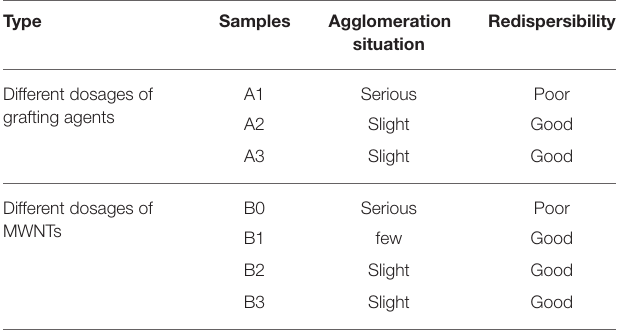
TABLE 3 | Redispersibility observation of prepared MR fluids.